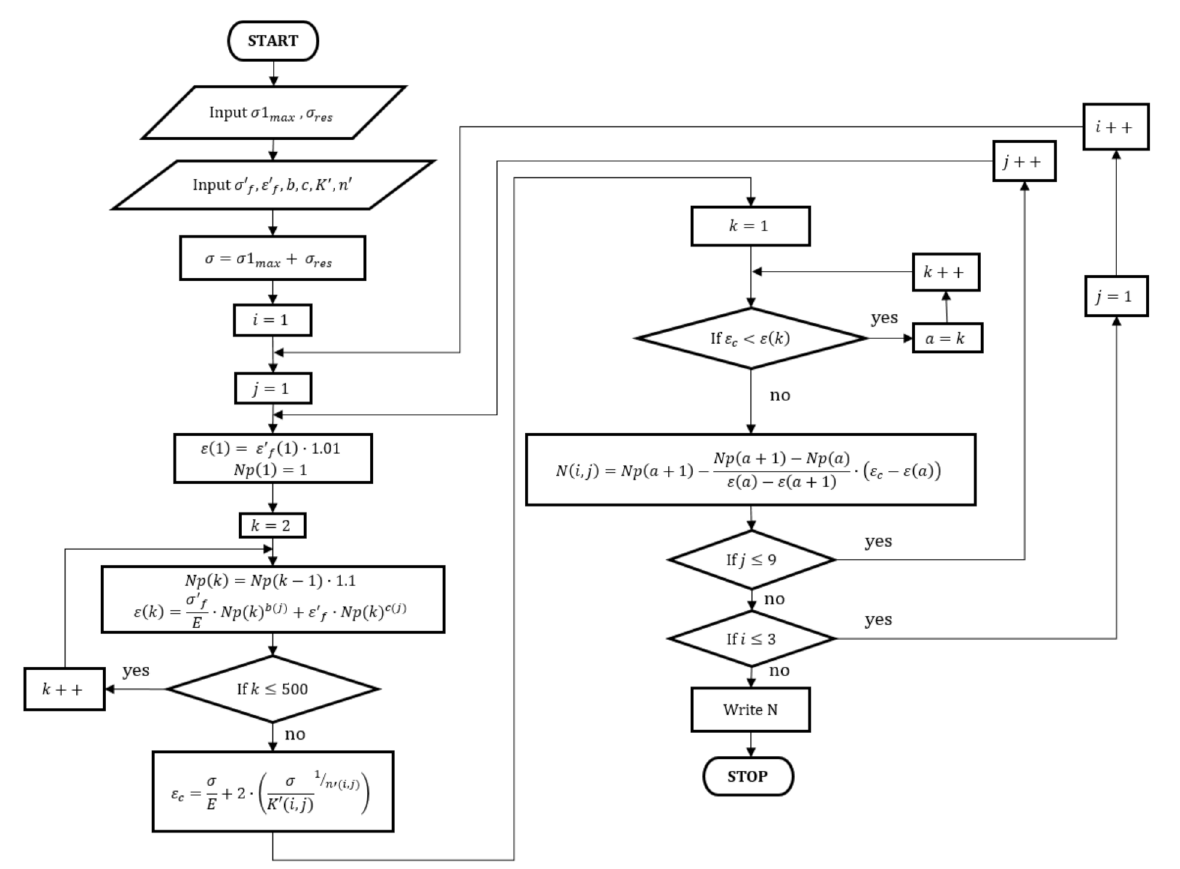
Figure 8. Scheme of the fatigue life assessment